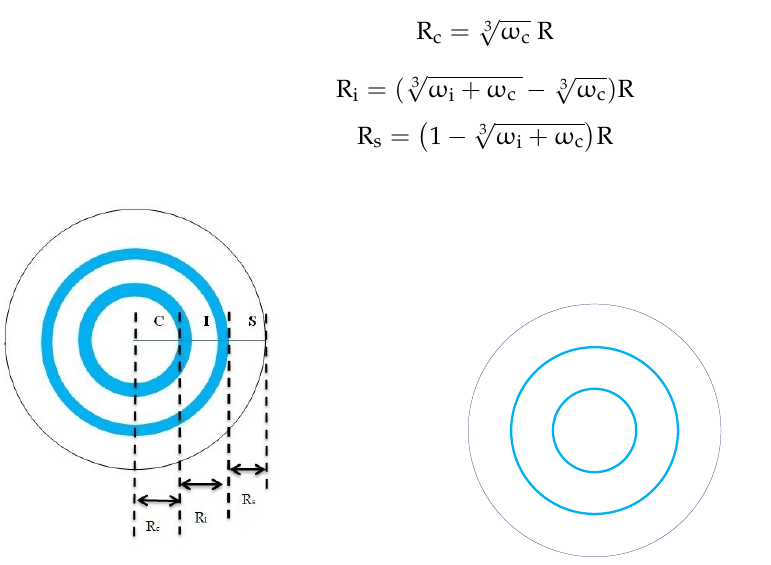
Figure 3. Diagram of latex particle model with a “core-intermediate-shell” three-layer structure. According to Formula (9)–(11), the radius of the core phase R c , the thickness of the intermediate layer R i , and the thickness of the shell R s can be calculated, respectively. The calculated R i includes the set intermediate layer and the interphase